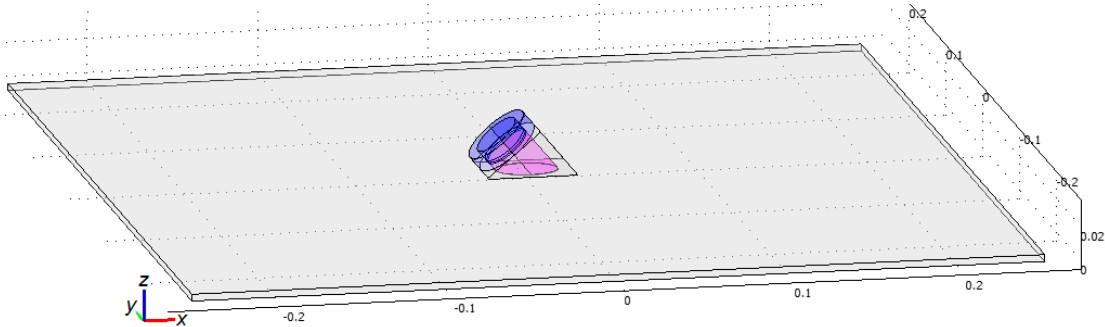
Figure 7. Geometry of the finite element model for the studied system.